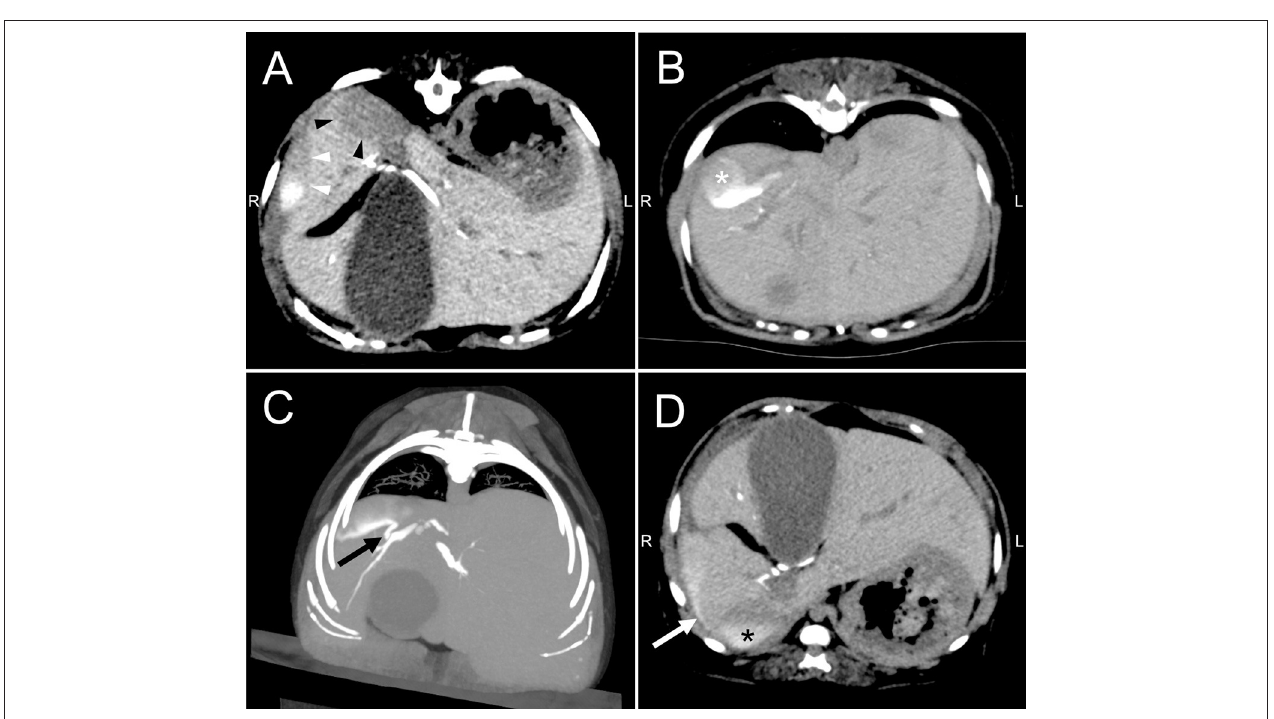
FIGURE 4 | Drip infusion cholecystocholangiography with computed tomography of the abdomen in a dog with biloma. (A) Transverse views revealed two well-defined large fluid collections, where one is in between right medial and lateral lobe (white arrow-head) and the other in between the right lateral lobe and caudate process of caudate lobe (black arrow-head). (B) The CT images showed that fluid collection was enhanced by the contrast agent (white asterisk) in the ventral recumbent position. (C) The reconstruction image showed communication between the fluid collection and intrahepatic bile duct of right lateral lobe (black arrow). (D) Drip infusion cholecystocholangiography with computed tomography images after repositioning to dorsal recumbency showed that the leaked contrast agent fell dorsally via gravity (white arrow) and confirmed communication between each fluid collections (black asterisk).